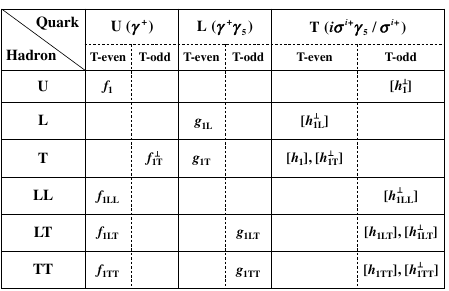
Table 1: Twist-2 TMDs.